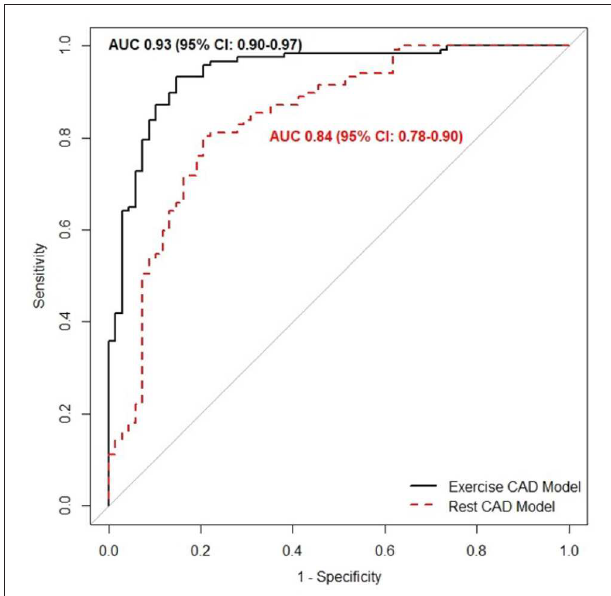
FIGURE 3 | The area under the curve of the receiver operating characteristic of the CAD rest (dashed line), which was trained over the features extracted merely from the rest SCG cycles, and the CAD exrc model (solid line), which was trained over the features extracted from the rest and immediately after exercise SCG